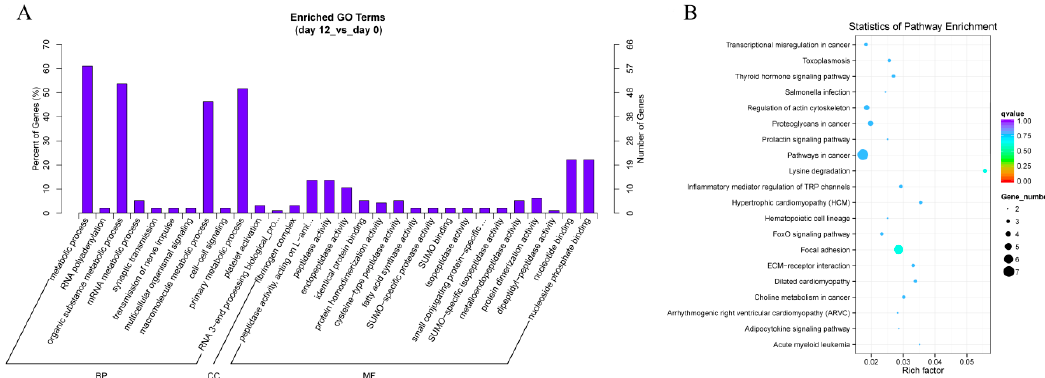
Figure 6. Annotations and enrichment of differentially expressed circRNAs. ( A ) GO analysis shows significantly (day 12 vs. day 0) enriched terms ( p < 0.05) in biological process, molecular function, and cellular component categories. ( B ) KEGG pathway analysis shows differentially expressed (day 12 vs. day 0) circRNAs enriched in the adipocytokine signaling pathway, extracellular matrix (ECM)-receptor interactions, forkhead box O (FoxO) signaling pathway, focal adhesion, lysine degradation, inflammatory mediator regulation of transient receptor potential (TRP) channels, thyroid hormone signaling pathway, and regulation of the actin cytoskeleton.